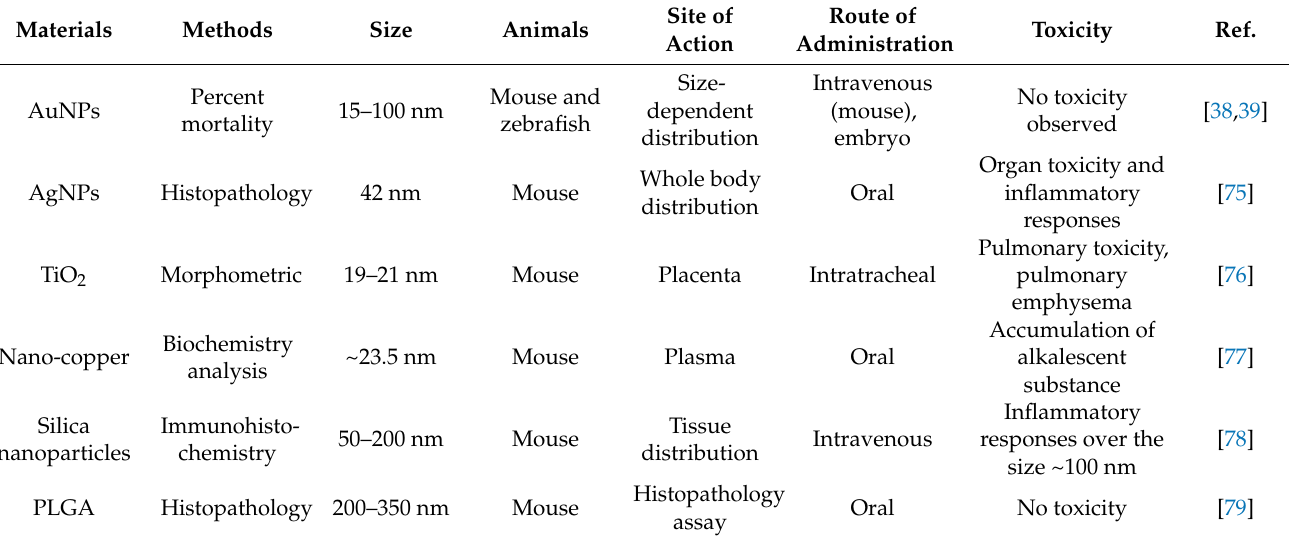
Figure 2. Photothermal treatment of PEG-SWCNTs has been shown here in mice. ( a ) schematic repre- sentation of the whole treatment procedure in mice; ( b ) mice bearing KB tumor cells; ( c ) photograph of the mice after administration of PEG-SWCNTs; ( d ) Irradiation of NIR on the tumor site (808 nm, 76 W/cm 3 ) for 3 min. Adapted with permission from Ref. [71]. 2009, American Chemical Society. Table 2. Summary of nanomaterials size effects on